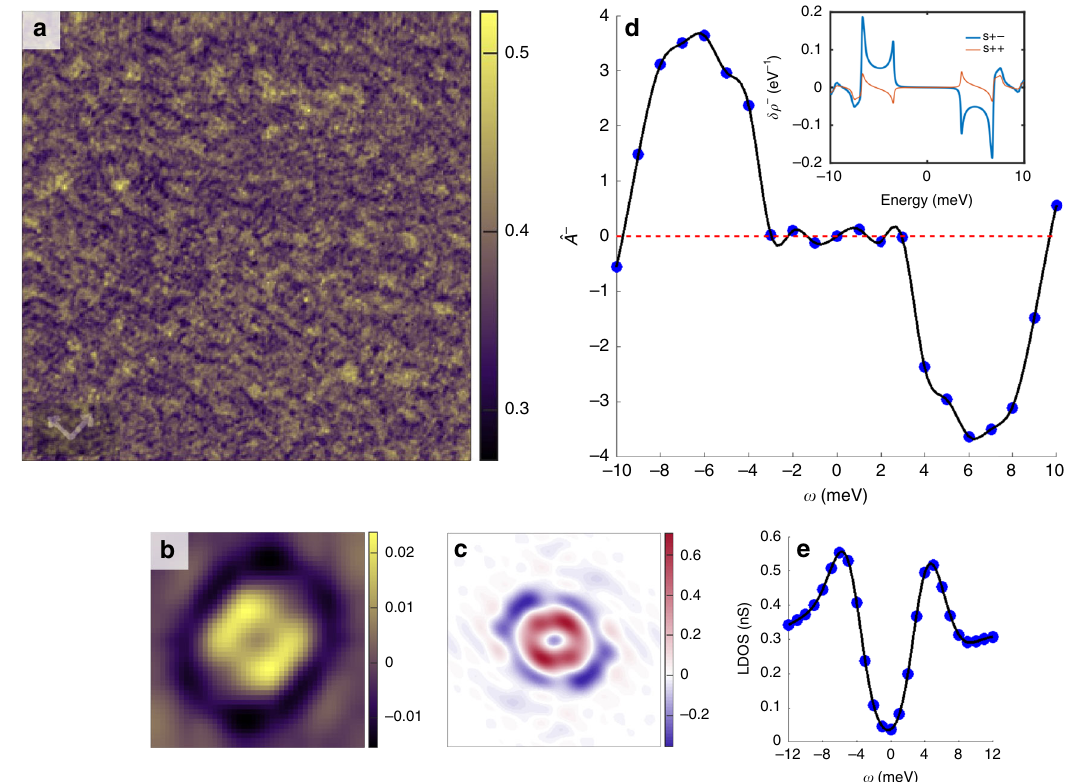
Fig. 6 Utility of phase-sensitive QPI. a Differential conductance map at ω = − 10 meV for an optimally doped NaFe 1 − x Co x As sample ( x = 0.02), over a 250 nm × 250 nm 2 fi eld of view with T = 5.9 K, I = 200 pA, and V set = − 50 meV. b Recovered kernel, ^ A , from the conductance map in a . c Fourier transform of the recovered kernel. d ^ A (cid:2) ð ω Þ , computed from the recovered kernels. The large and constant sign of the response is an indication of s ± pairing. (inset) theoretical expectations for s ± and s ++ pairing e Spatially averaged differential conductance from the same area as a function of energy, revealing the superconducting gap 2 Δ = 11 meV. The STM spectroscopy maps have been drift corrected as outlined in Supplementary Note